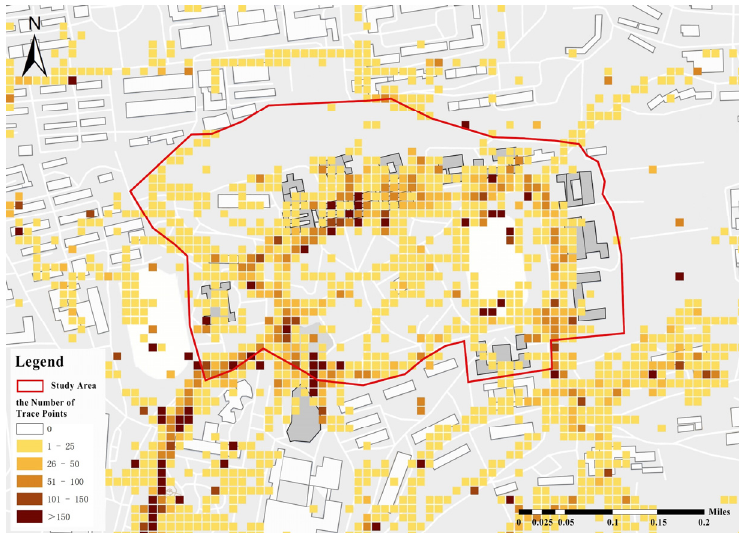
Figure 8. Point density analysis of trajectory data.